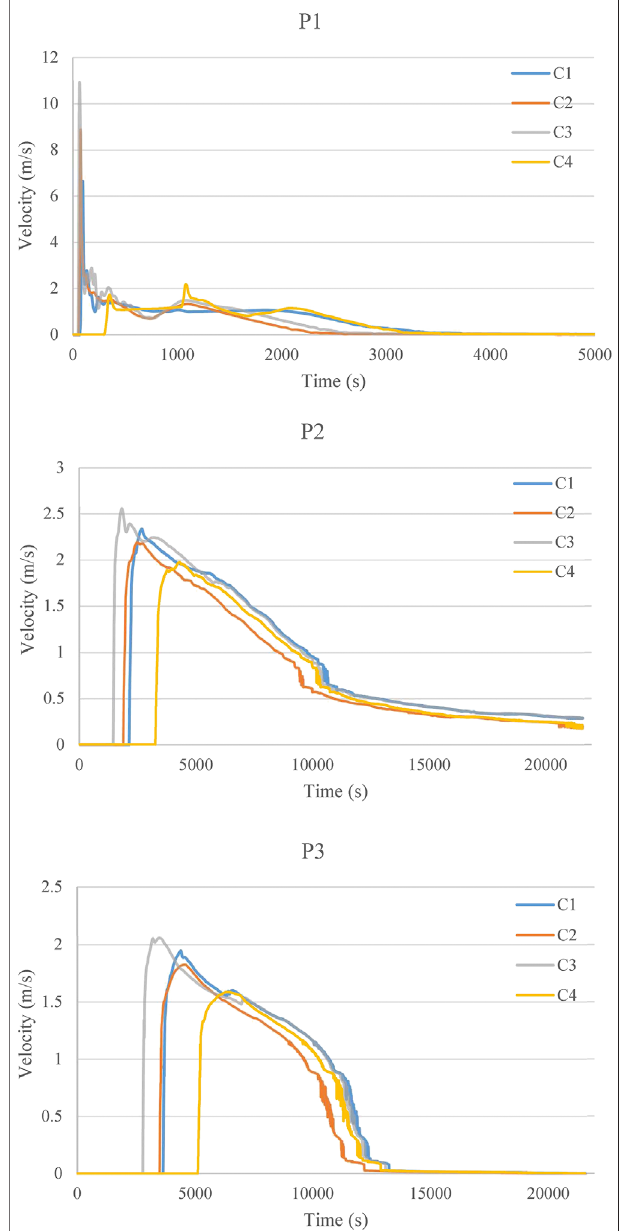
FIGURE 6 | Velocity – time graphs at P1, P2, and P3 under condition C1 –